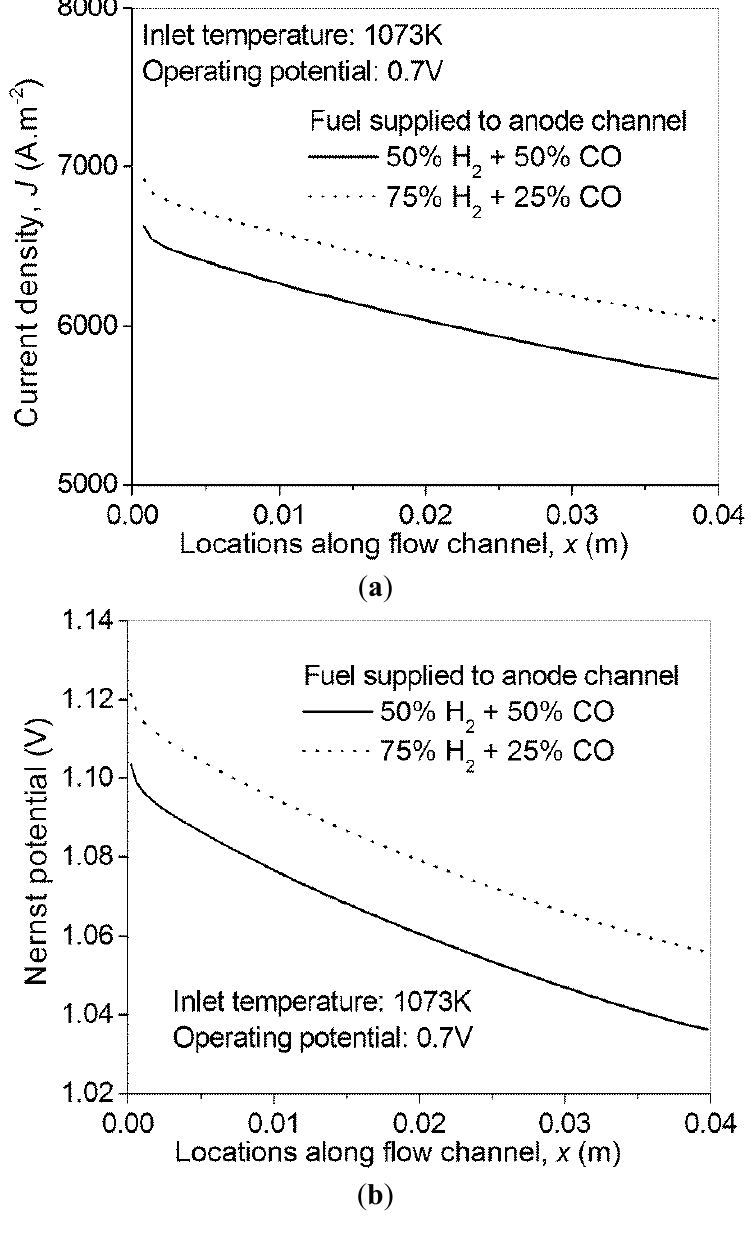
Figure 2. Effect of syngas composition on the performance of H-SOFC—( a ) current density distribution; ( b ) Nernst potential